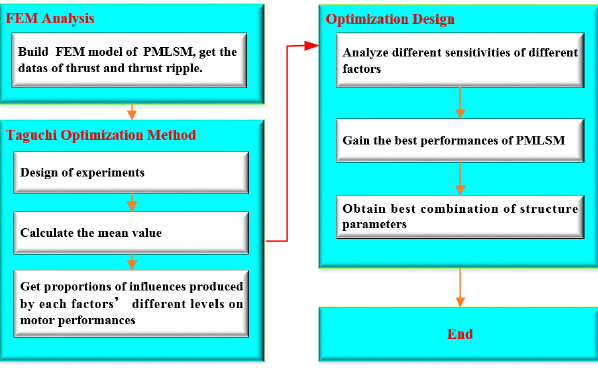
Figure 3. Framework of Taguchi optimization method.